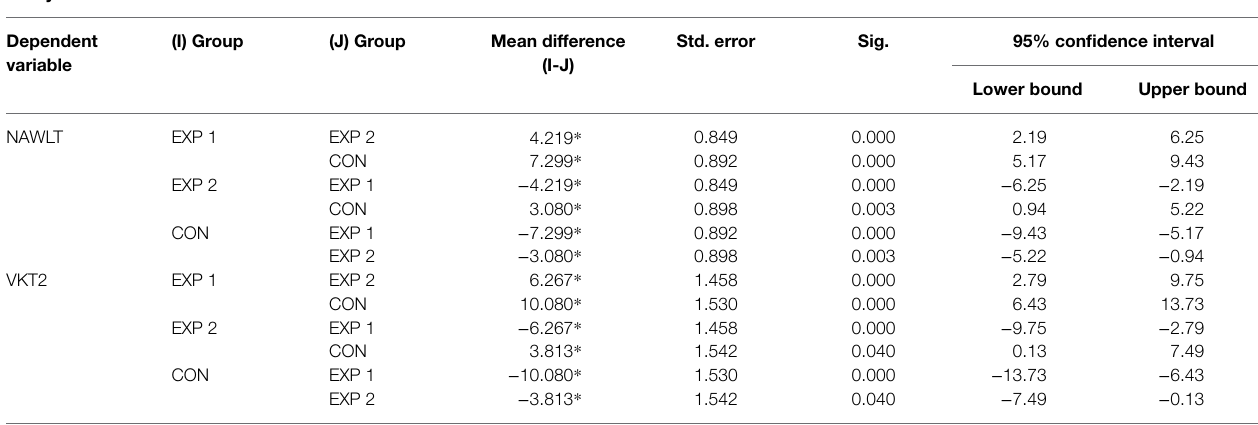
TABLE 7 | Multiple